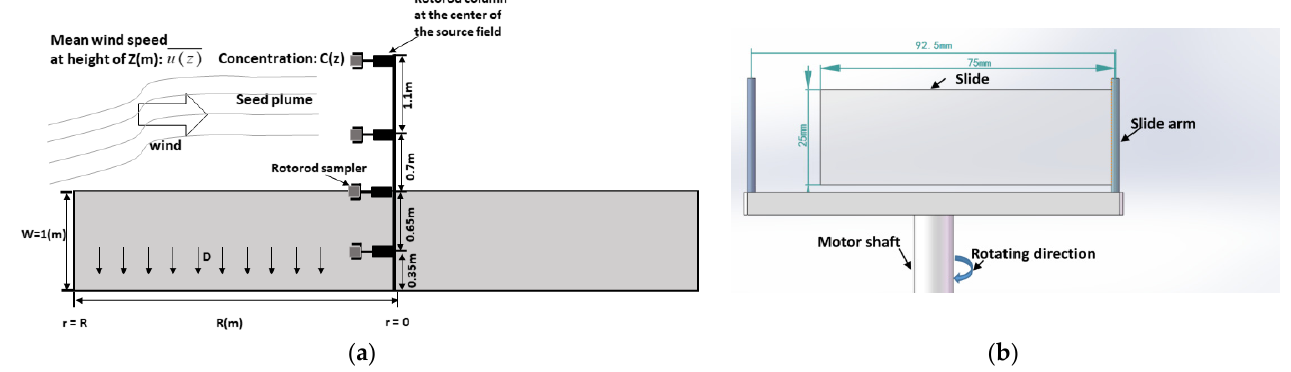
Figure 13. ( a ) Schematic sketch of seed source strength measurement ( Q 0 , grains/plant/s) in the source fields, where r was the distance from the Rotorod sampling column at the field center, R is the length of the field edge to the sampling column, in the Tennessee field, R was equal to the radius of the field, C (z) was the concentration (grains/m 3 ), u ( z ) (m/s) was the horizontal mean wind speed, Z (m) was the height of the Rotorod sampler, D represented the downward deposition of seed grains. ( b ) Schematic sketch of the sampling head of the Rotorod sampler. The diameter of the aluminum rotating rod was 92.5 mm. The microscope slides were 25 × 75 mm. Seed vertical concentration (grains/ m (cid:2871) ) profiles intended for calculating the seed re- lease rate, were usually measured at the field centers. In Illinois, one-column Rotorod samplers (RC1, Figure 11) worked for this. These Rotorod samplers were mounted at heights of 0.35 m, 1 m (i.e., the height of the canopy), 1.7 m, and 2.8 m above the ground (Figure 11b,d). In Tennessee, a column of five Rotorod samplers (HP1, Figure 12) was mounted on a mast in the center of the circular field. These samplers were at a height of 0.5 m (i.e., height of the flowers), 1.3 m (i.e., height of the canopy), 2.23 m, 3.15 m, and 5 m above the ground (Figure 12b). Meanwhile, wind speeds were measured to estimate the horizontal flux density. In addition, additional recording samplers were set up in the cen- ter of the source fields at the canopy height (1 m in Illinois and 1.3 m in Tennessee) to measure the seed release rate uninterruptedly (CR, Figures 11 and 12), which was the ref- erence value of the source strength when the other samplers were switched off to insert fresh slides. Seed concentration along the downwind direction could reflect the dispersion of the seeds with the wind. In Illinois, one-column Rotorod samplers (RC2, Figure 11) were set up at the northeast edge of the source field. Samplers were at 1, 1.5, and 3 m heights. Another two columns of Rotorod samplers (CB1, CB2, Figure 11) were mounted beneath two balloons to collect the concentration data at greater heights, ranging from 10 to 100 m. The two balloons floated in the downwind direction, one inside and one outside of the field at a maximum distance of 1000 m downwind and away from the edge of the source field. The downwind distance of the balloons and the sampler heights were adjusted de- pending on whether seeds were detectable. Outside of the field in Tennessee, a series of Rotorod slides were placed 0.5 m high at several distances downwind from the source field (HR9-HR12, HR14, HR16, Figure 12) to observe seed concentration dispersion. Be- sides these samplers, two masts were set up at 4 and 16 m downwind from the edge of the source plot, with Rotorod samplers at 0.5, 1.3, 3.15, and 5 m heights (HP2, HP3, Figure 12). Horseweed seeds that adhered to the slides were approximately 1.6–6.4 mm long and were easy to distinguish from other debris and to count. The seed concentration (C, grains/ m (cid:2871) ) was calculated as the total sampled seed number on each slide divided by the sampled air volume calculated as a function of the rotation speed, sampling time, and slide area of the corresponding Rotorod sampler [34].